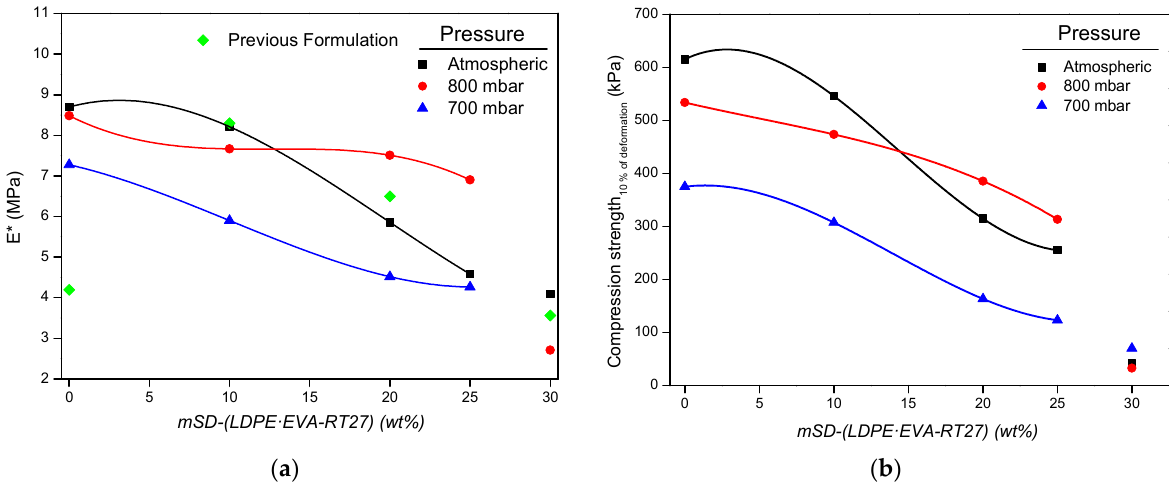
Figure 9. Young´s modulus ( a ) and compression tension at 10% deformation ( b ) for the composite foams synthetized at different operating pressures.